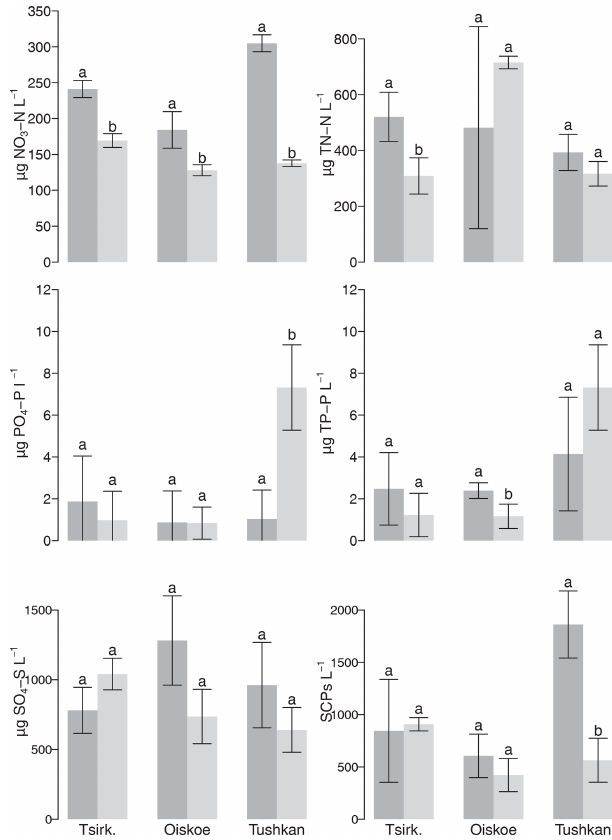
Figure 3. Chemical composition of upper (dark gray) and lower (light gray) layers of the 2016–2017 snowpack in the Ergaki moun- tains. All values are in µgL − 1 except SCPs (countsL − 1 ). Bars rep- resent mean values, and whiskers represent the standard deviation. The two upper layers were averaged in Tsirkovoe, where the snow core was divided into three layers. Column pairs with letters “a” and “b” are significantly different (one-way ANOVA, p - v < 0 . 05 in the case of nitrate and t tests in the other cases; n = 3 except in Tsirkovoe, where the upper layer is n = 4 and the lower layer is n =